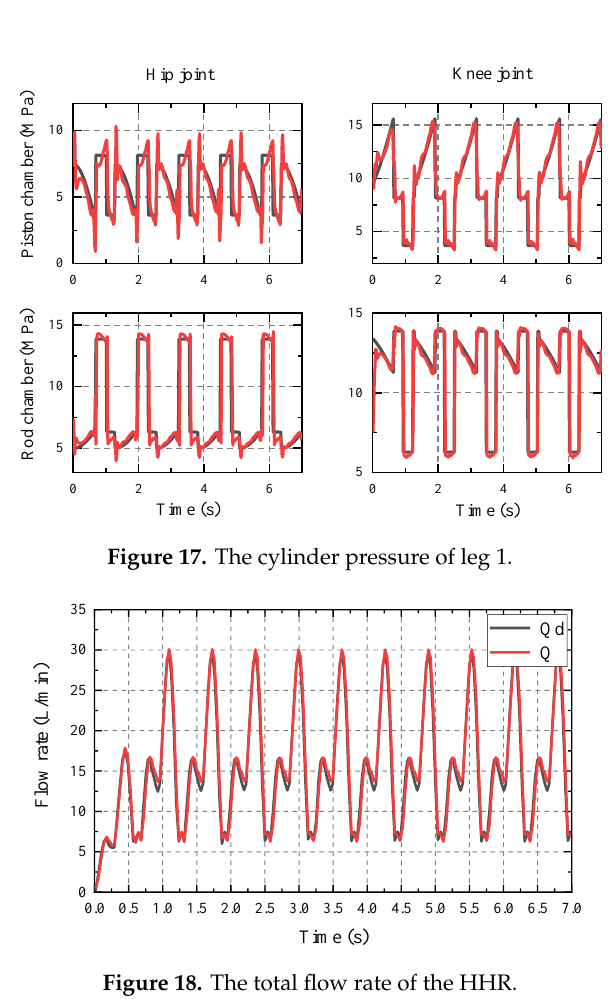
Figure 16. Forward velocity of the HHR.